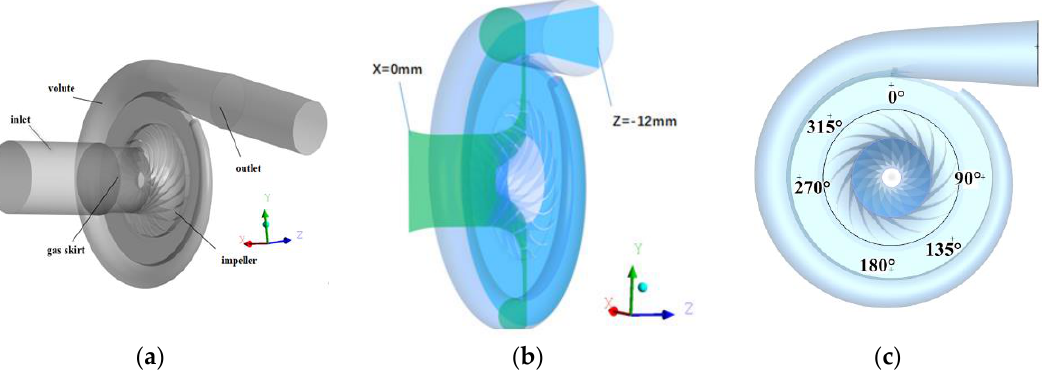
Figure 1. ( a ) Geometry of the centrifugal compressor; ( b ) Cross-sectional diagram showing the centrifugal compressor at x = 0 mm and z = −12 mm; ( c ) Description of orientations in the work. Table 1. Main geometrical parameters of the centrifugal compressor. Geometrical Parameters Value Inlet diameter (mm) 228 174 25 Number of blades